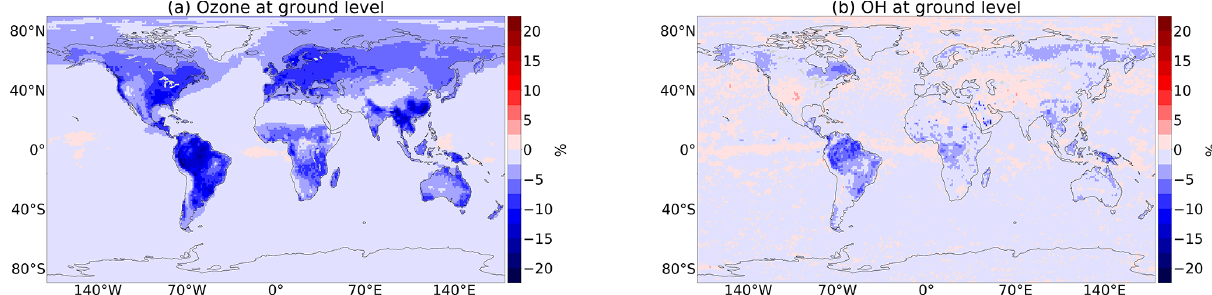
Figure 10. Relative change of multiyear (2010–2015) mean at ground level (DEF – REV).